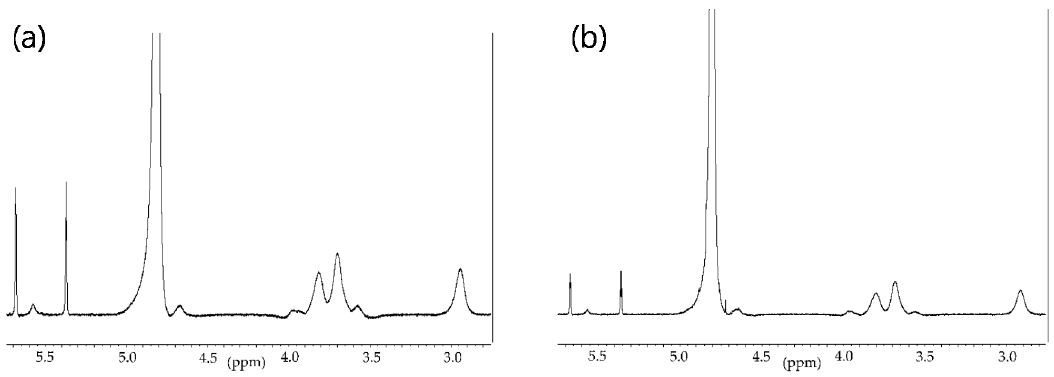
Figure 2. 1 H-NMR spectra of ( a ) low-methacrylamide chitosan (MC) gallic acid (GA); and ( b ) high-